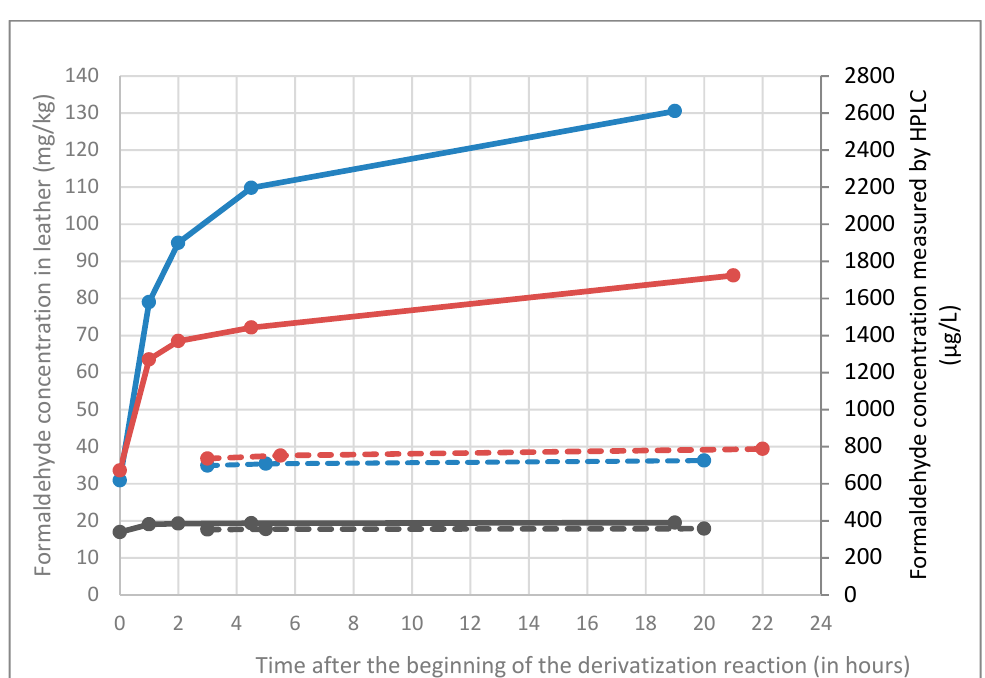
Figure 6. Formaldehyde content over DNPH derivatization reaction time; two derivatization conditions used: EN ISO 17226-1 standard conditions (solid lines), DNPH in acetonitrile at 50 °C during 3 h (dashed lines); lambs tanned with chrome and retanned without resin (in black) or with dicyandiamide resin (in blue) or melamine resin (in red).